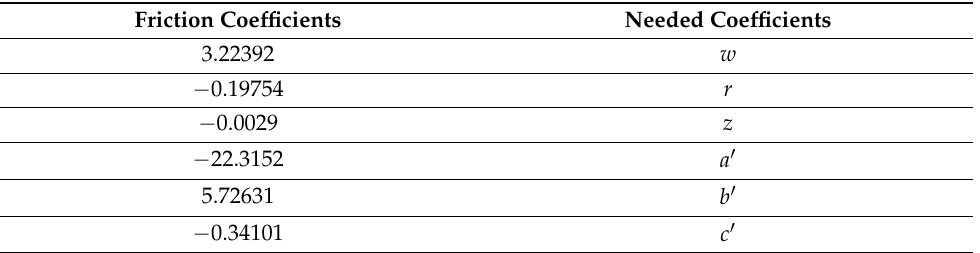
Table 4. Coefficients required to solve equations of Table 2 in terms of thermal resistance coefficient at different weight concentrations [54,55].